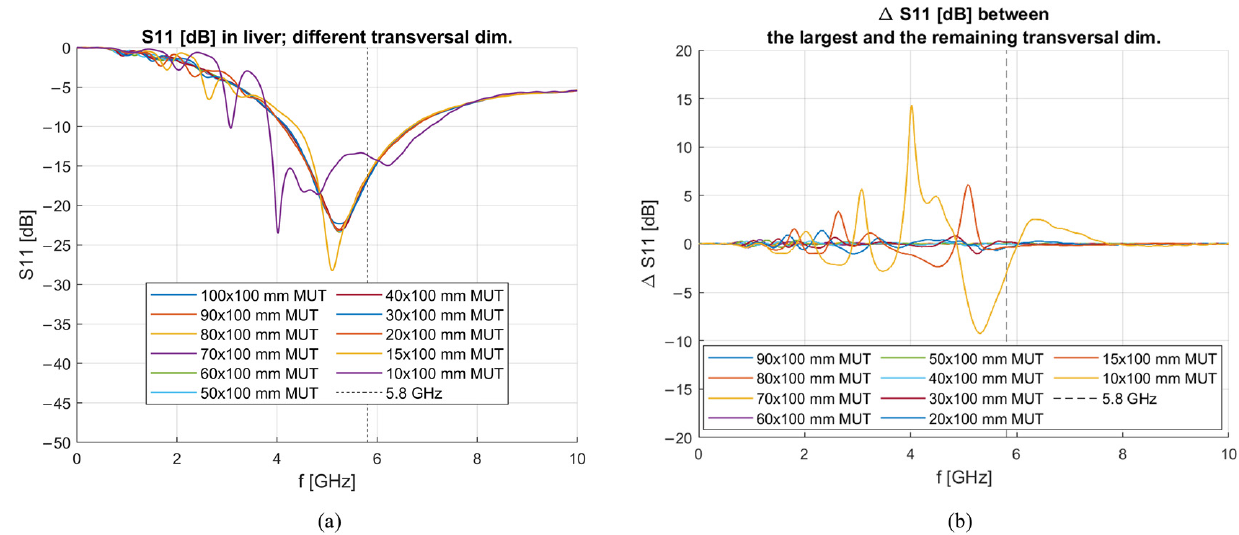
Figure 15. ( a ) Reflection coefficient in dB simulated in livers of different sizes (all edge lengths); ( b ) Reflection coefficient differences between simulations performed in livers of different sizes (all edge lengths).